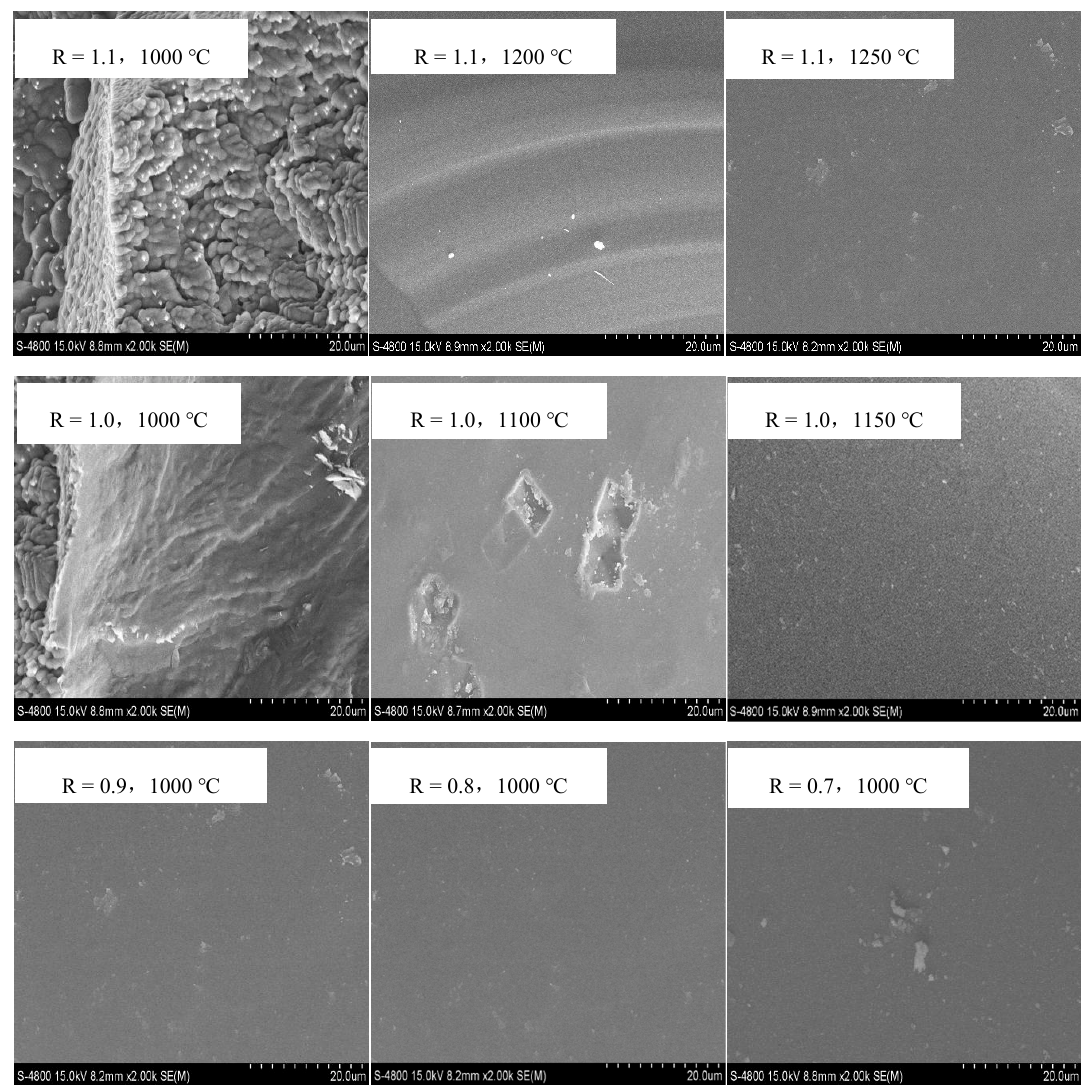
Figure 5. SEM analysis of BFS with different basicities.